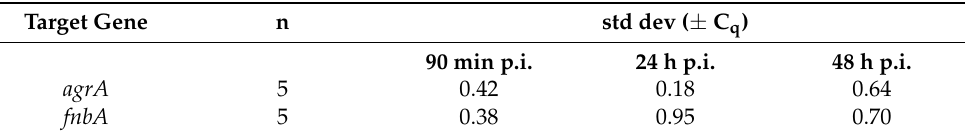
Table 6. Std dev of target genes of intracellular S. aureus at 90 min, 24 h, and 48 h postinfection (condition II). n: number of independent experiments carried out for each condition; std dev: standard deviation; C q : crossing